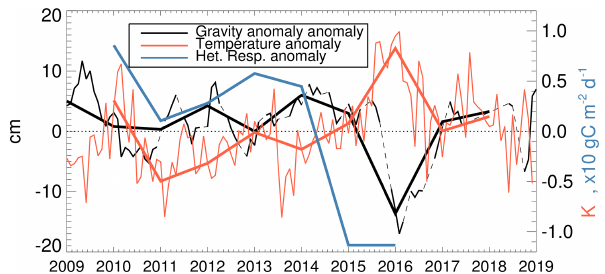
Figure 7. Anomalies of gravity anomaly (cm, black, left axis), surface temperature (K, red, right axis) and heterotrophic respira- tion ( × 10gCm − 2 d − 1 , blue, right axis) for the period 2009–2018 within the Amazon basin. Monthly mean anomalies are shown as thin lines, whilst wet season (December–March) averages are shown as thick lines. Interpolated values for gravity anomalies are shown as dashed